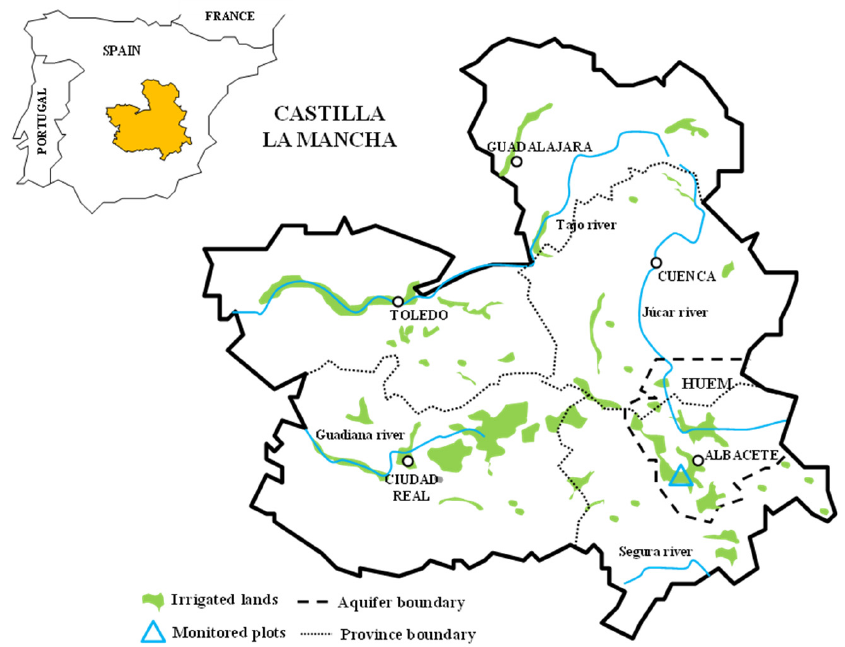
Figure 1. Location of the monitored area in southeastern Spain. HUEM: hydrogeological unit of eastern Mancha.